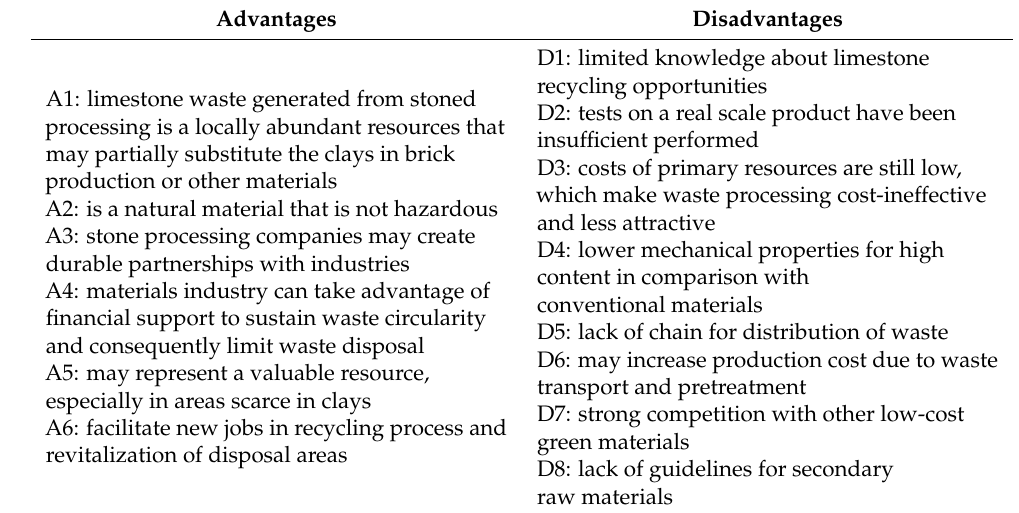
Table 3. Advantages and disadvantages of using limestone in the clay